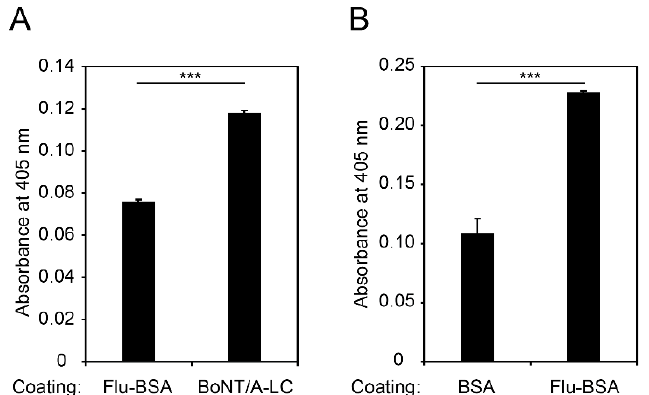
Figure 3. Binding capabilities of BoNT/A-LC and fluorescein-binding VHH grafts. ( A ) ELISA of the BoNT/A-LC-specific VHH graft. Wells were coated with fluorescein-conjugated BSA (negative control) or BoNT/A-LC and the binding of VHH (5 µ g/mL) was assessed. ( B ) ELISA of the fluorescein-specific VHH graft. Wells were coated with BSA (negative control) or fluorescein-conjugated BSA and the binding of VHH (100 µ g mL − 1 ) was evaluated. Mean values of three replicates ± SEM are shown. Statistical analysis: unpaired t -test, *** p <